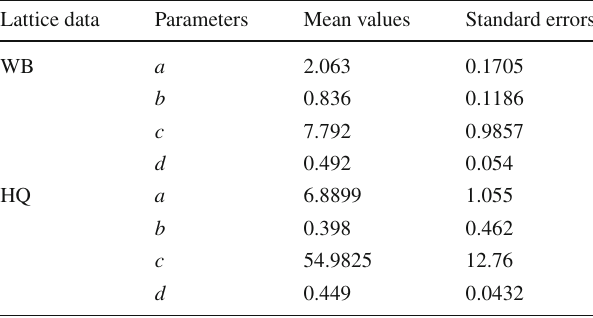
Table 2 The mean and standard deviations of parameters ( a , b , c , d ) in the coupling g ( T ) extracted from Wuppertal–Budapest and Hot